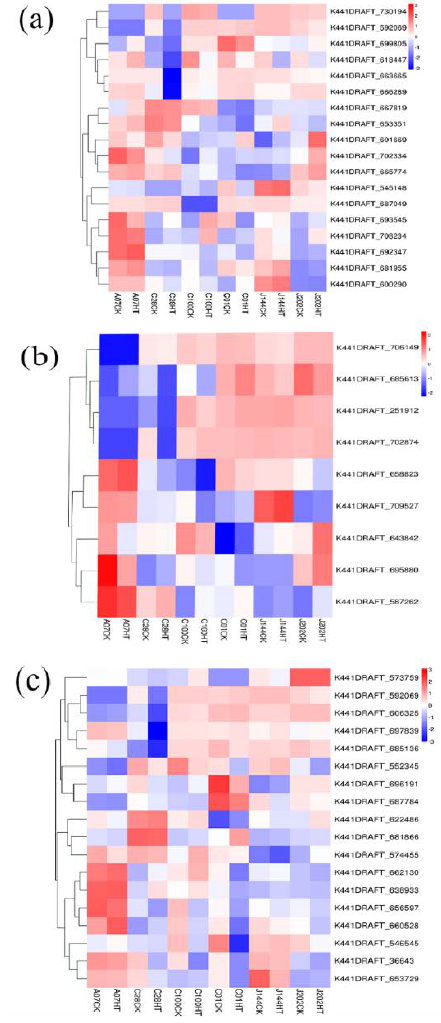
Figure 8. ( a ) Heatmap of genes annotated for the “fatty acid degradation” pathway in six isolates under high temperature treatment, ( b ) heatmap of genes annotated to the “ABC transporter” pathway in three tolerant isolates under high temperature treatment, ( c ) heatmap of genes annotated to the “glyoxylate and dicarboxylate metabolism” pathway in three sensitive isolates under high temperature treatment.